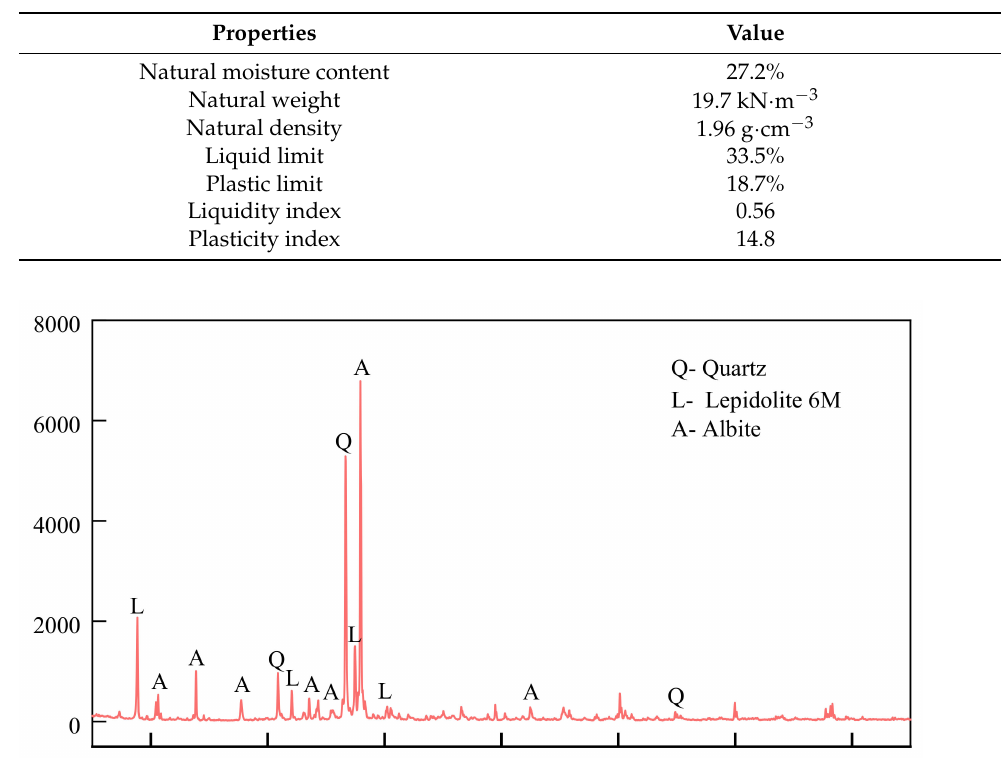
Figure 1. Images of the soil and LS used in the experiment: ( a ) soil and ( b ) LS. Table 3. Basic physical indexes of soil.